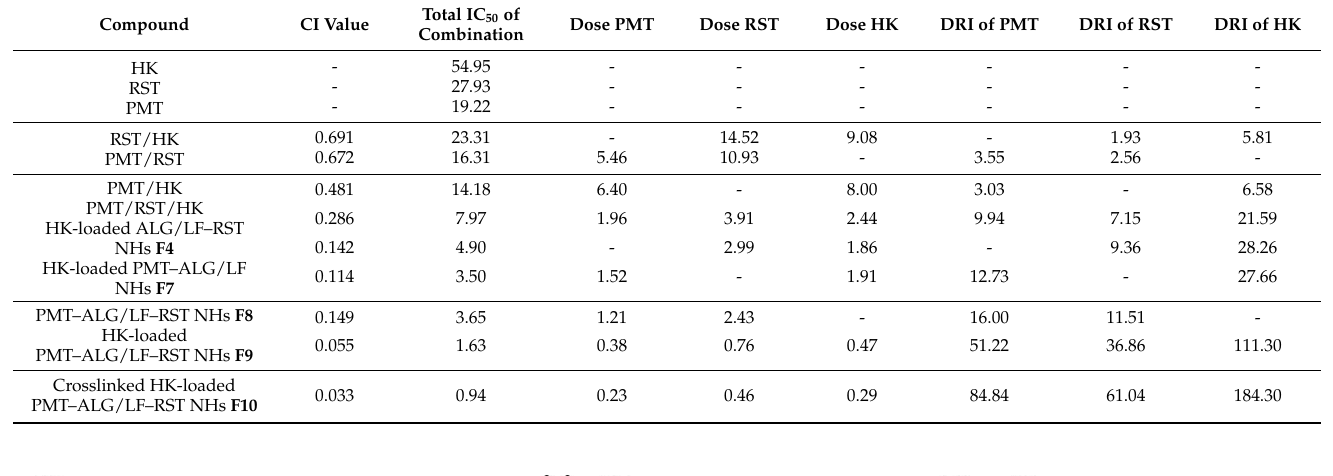
Table 4. CI, IC 50 and DRI values of free drugs in comparison to the synthesized NHs against MCF-7 breast cancer cells after 24 h at concentrations of 0–100 µ M.